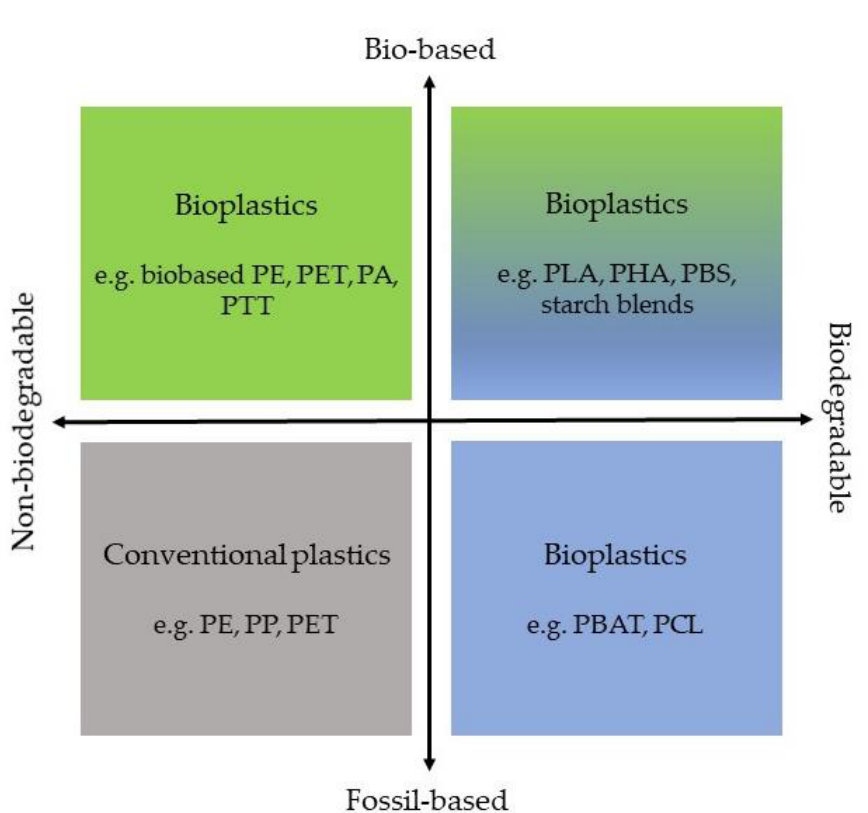
Figure 1. Classification of plastics used for packaging applications. Adapted from [95]. Poly(amide) (PA), poly(butylene adipate terephthalate) (PBAT), poly(butylene succinate) (PBS), poly(butylene succinate) (PBS), poly(caprolactone) (PCL), poly(ethylene) (PE), poly(ethylene terephthalate) (PET), poly(hydroxyalkanoate) (PHA), poly(lactic acid) (PLA), poly(propylene) (PP), poly(trimethylene terephthalate) (PTT).